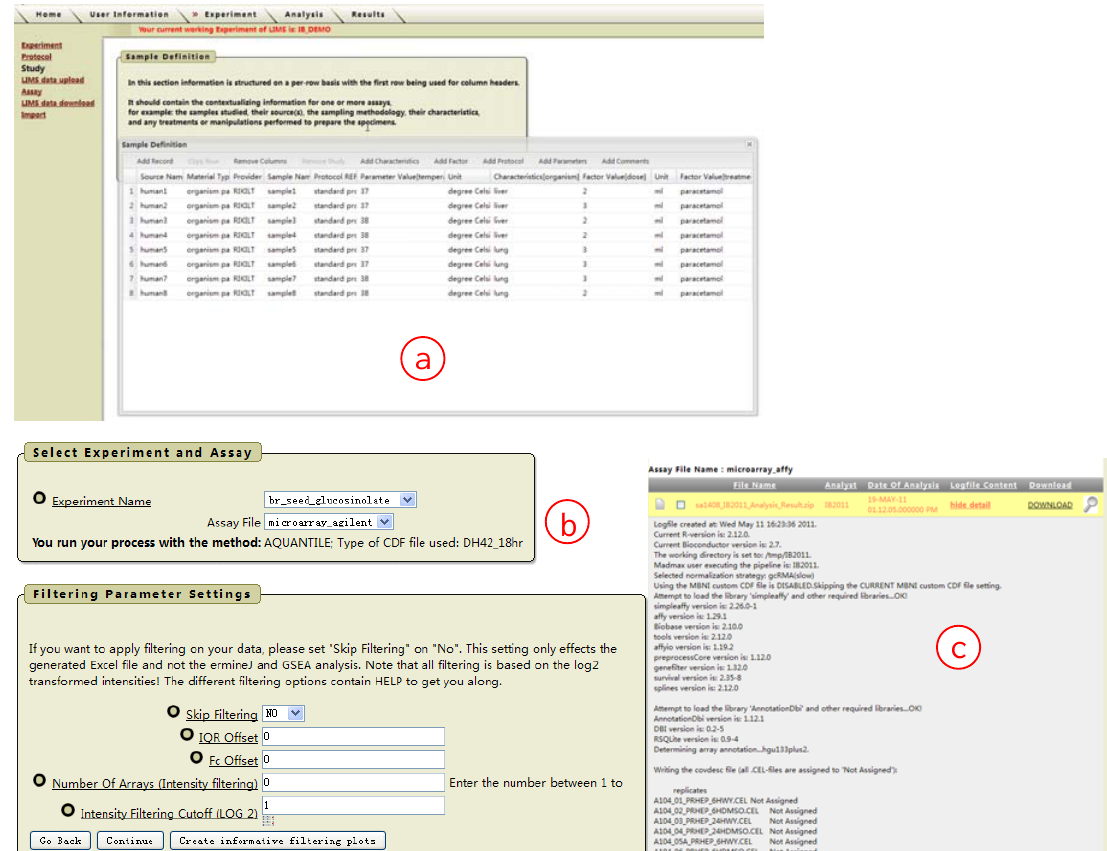
Figure 2: The web user interfaces of MADMAX. a. Form to fill in the sample related information which is content of study file in ISA-Tab specification, eg. sampling methodology, characteristics, factor value of each sample. b. Microarray statistical analysis interface in MADMAX. It need normalization, group assignment and filtering steps before user can run statistical tests. c. Analysis results download page. The individual analysis results of each assay can be downloaded and the detailed process information can be viewed as well. The highlighted results are standard of each assay which can be used for the integration